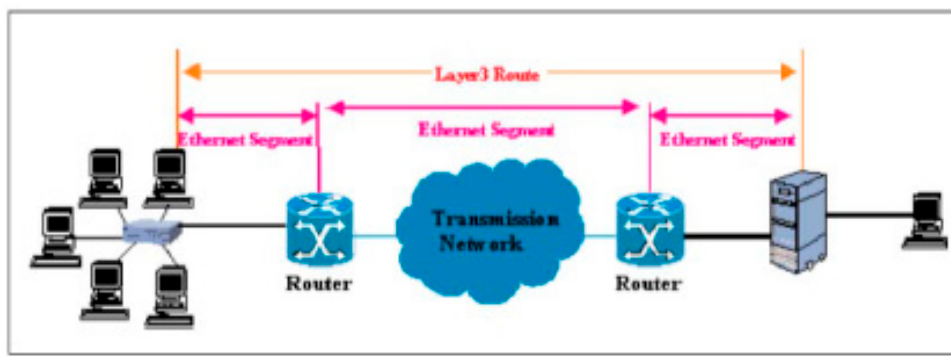
Figure 1. Carrier Ethernet system with multiple sections.